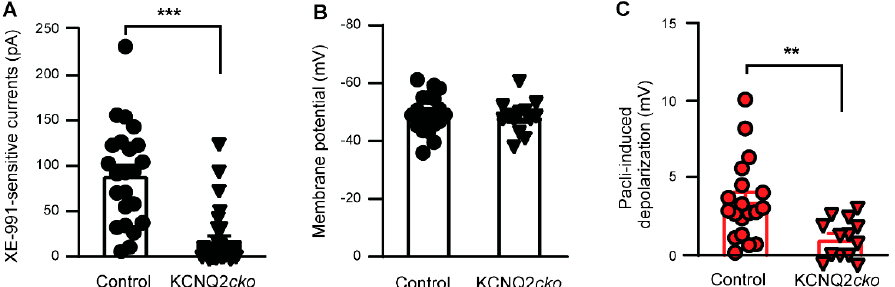
Figure 3. Effect of KCNQ2 deletion from primary sensory neurons on the paclitaxel- and XE-991- induced response. ( A ) XE-991 (10 µ M)-sensitive currents in DRG neurons from control and KCNQ2 cko mice. p < 0.001, t(52) = 6.181, unpaired t test (two-tailed). Black symbols in columns represent one DRG neuron each. ( B ) Resting membrane potential of DRG neurons from control and KCNQ2cko mice. p = 0.593, t(30) = 0.541, unpaired t test (two-tailed). Black symbols in columns represent one DRG neuron each. ( C ) Paclitaxel (3 µ M)-induced membrane depolarization of DRG neurons from control and KCNQ2 cko mice. p = 0.0038, t(30) = 3.137, unpaired t test (two-tailed). Filled symbols in columns represent one DRG neuron each. **, p < 0.01; ***, p < 0.001.